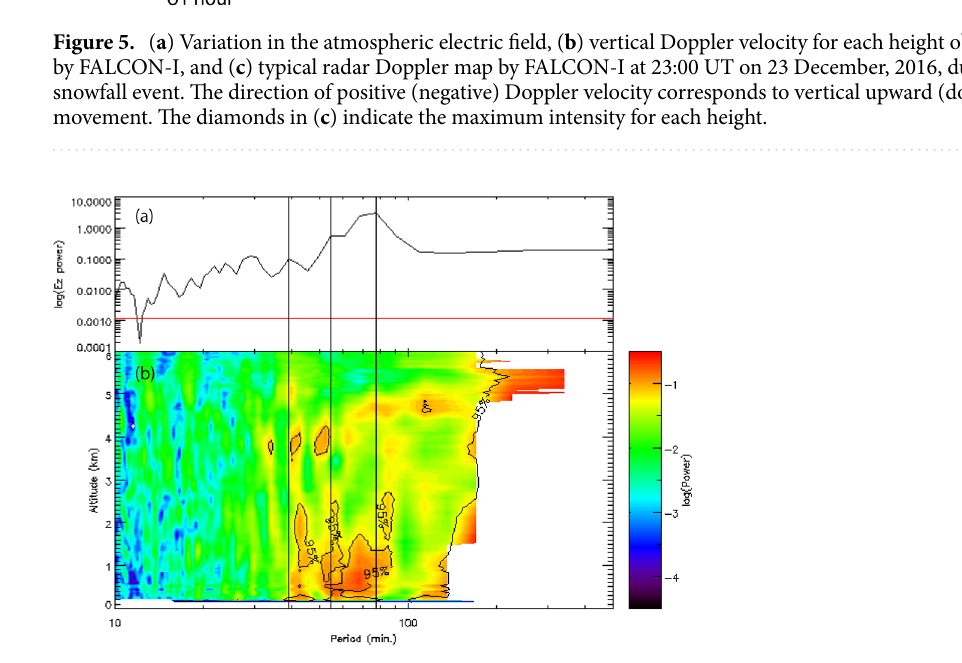
Figure 6. ( a ) Periodogram of the atmospheric electric field at CHB, and ( b ) period of the FALCON-I radar reflectivity for each height by the FFT. The red line in ( a ) indicates the 95% significance threshold. The three vertical black lines indicate the periods of 39.0, 54.6, and 78.0 min of the atmospheric electric